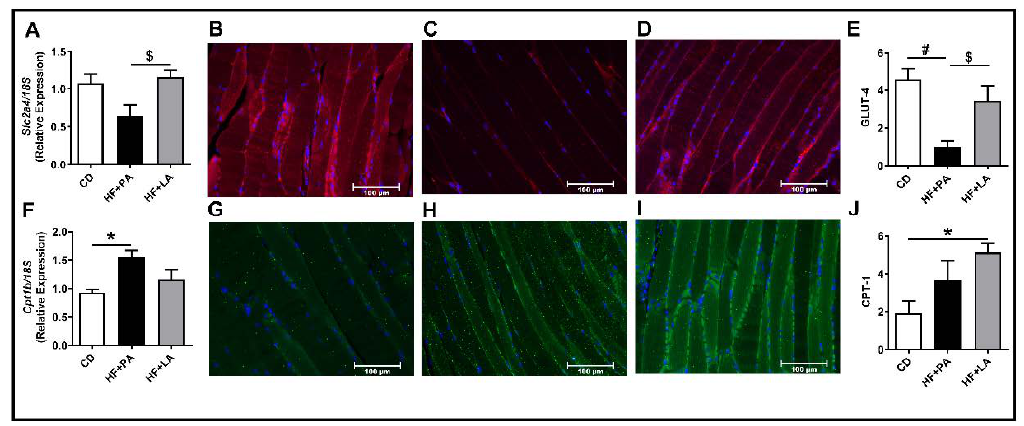
Figure 5. Effect of HF diet supplemented with PA or LA on markers of glucose and fatty acid transport in skeletal muscle. Quantitative real-time PCR analysis was performed in the skeletal muscle for the mRNA levels of genes involved in glucose and fatty acid transport/oxidation ( A , F ). Immunofluorescence analysis was carried out to determine the protein levels of GLUT-4 ( B – E ) and CPT-1 ( G – J ). Representative images at 20× magnification are shown. The intensity of staining was quantified and values are expressed as mean ± SEM of 6–8 samples in each group. * p < 0.05 and # p < 0.01 versus CD; $ p < 0.05 versus HF + PA. Slc2a4 (GLUT-4), Solute carrier family 2 (facilitated glucose transporter), member 4; Cpt1b, Carnitine palmitoyltransferase 1b; CD, chow diet; HF + PA, high fat + palmitic acid; HF + LA, high fat + lauric acid.